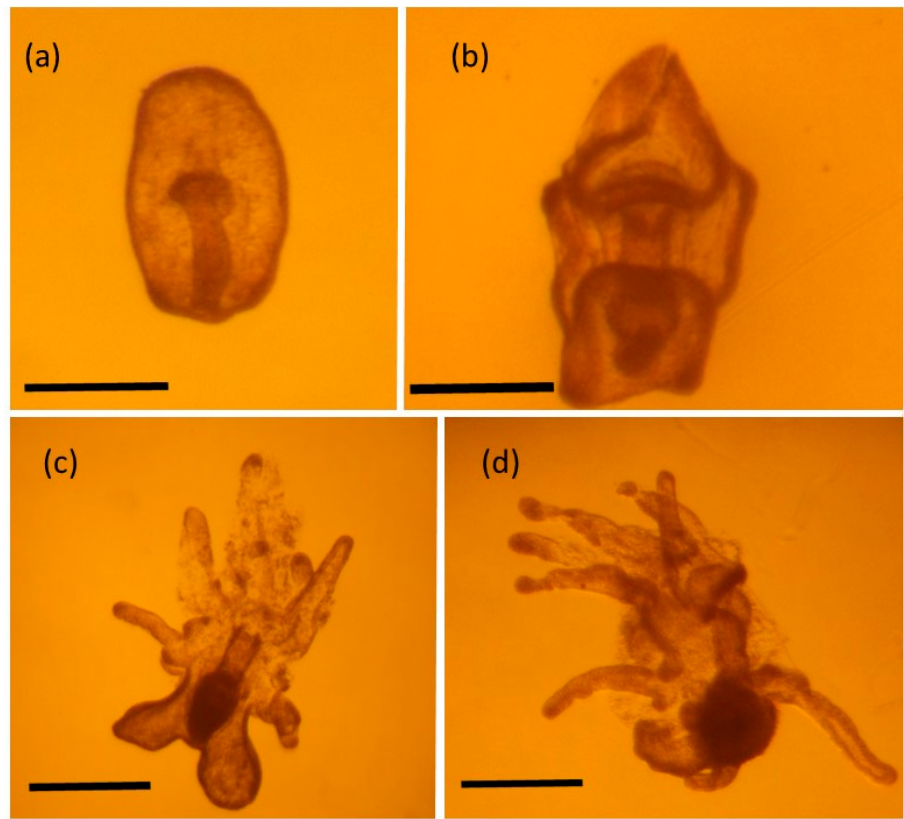
Figure 3. Field collected larvae with different developmental stages ( a ) gastrula, ( b ) bipinnaria and ( c,d ) brachiolaria larvae. Bars indicate 200 µm.